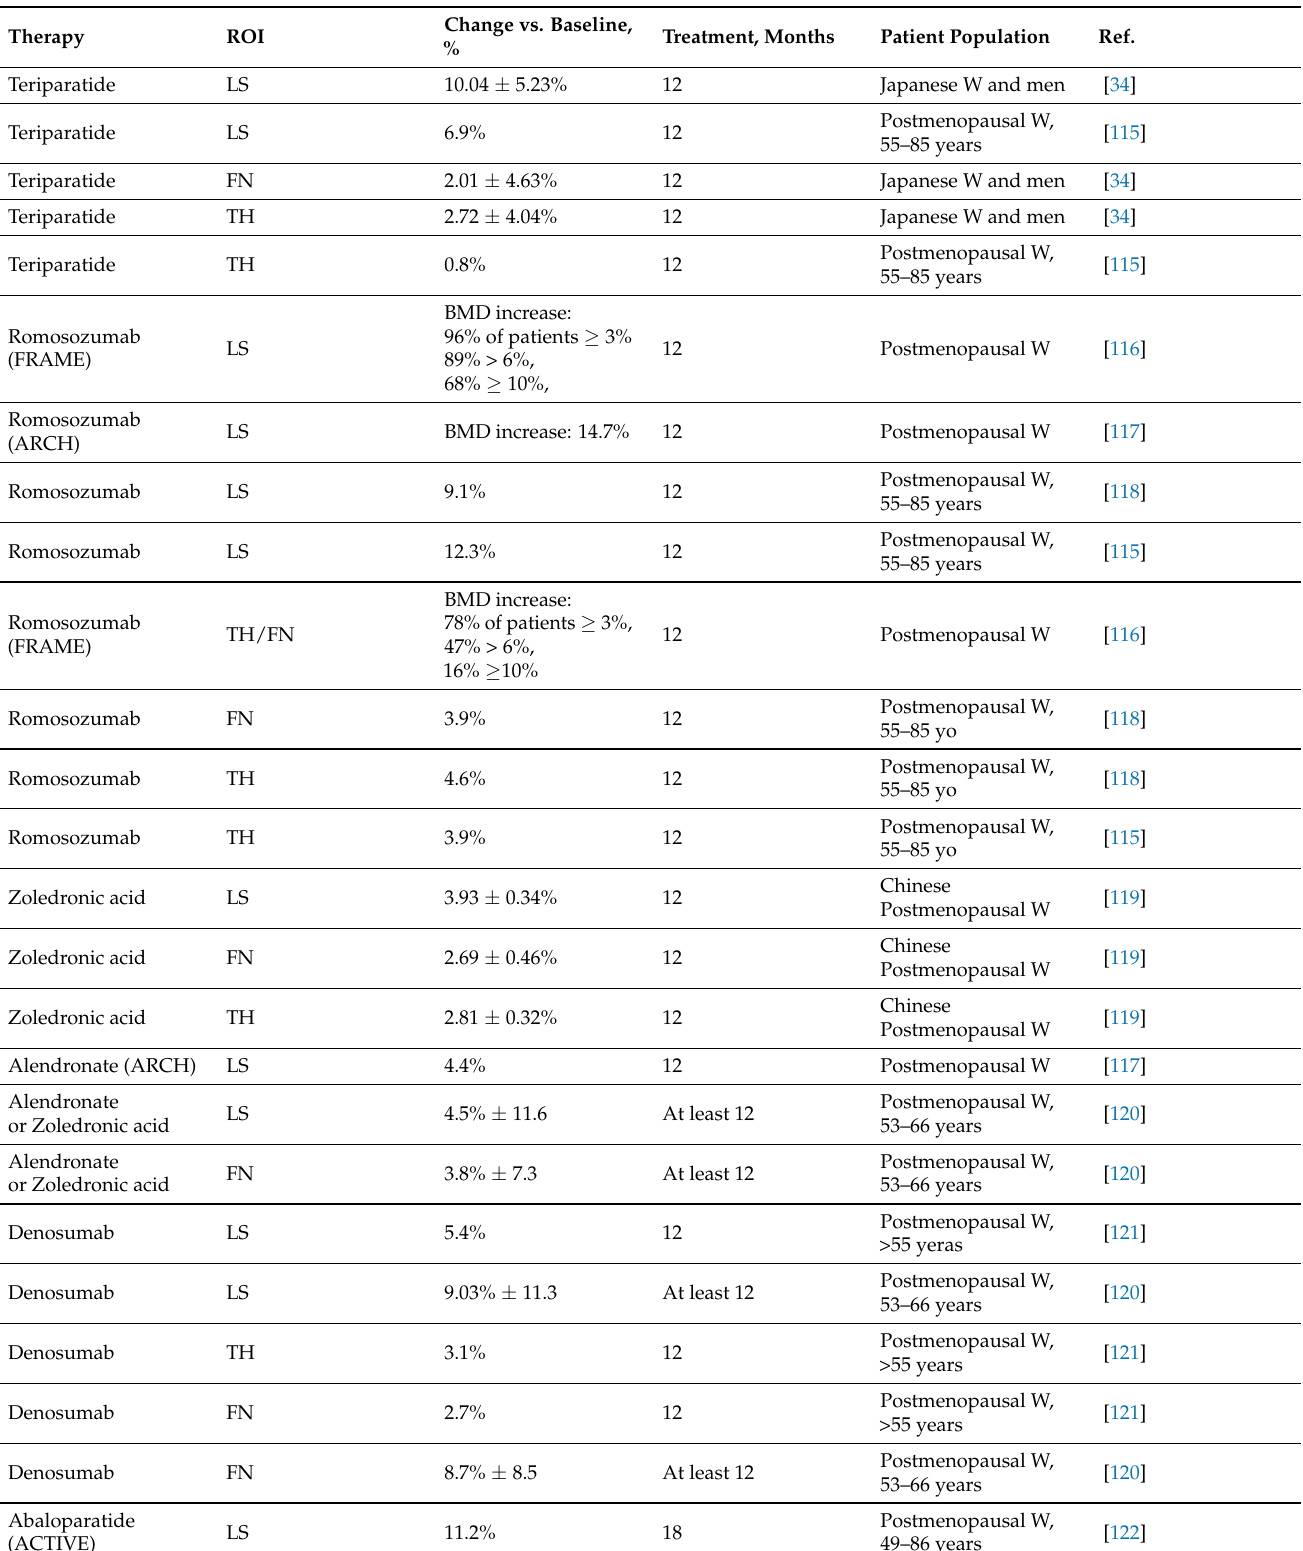
Table 4. Effect of anti-osteoporosis medications treatment for 12–18 months on